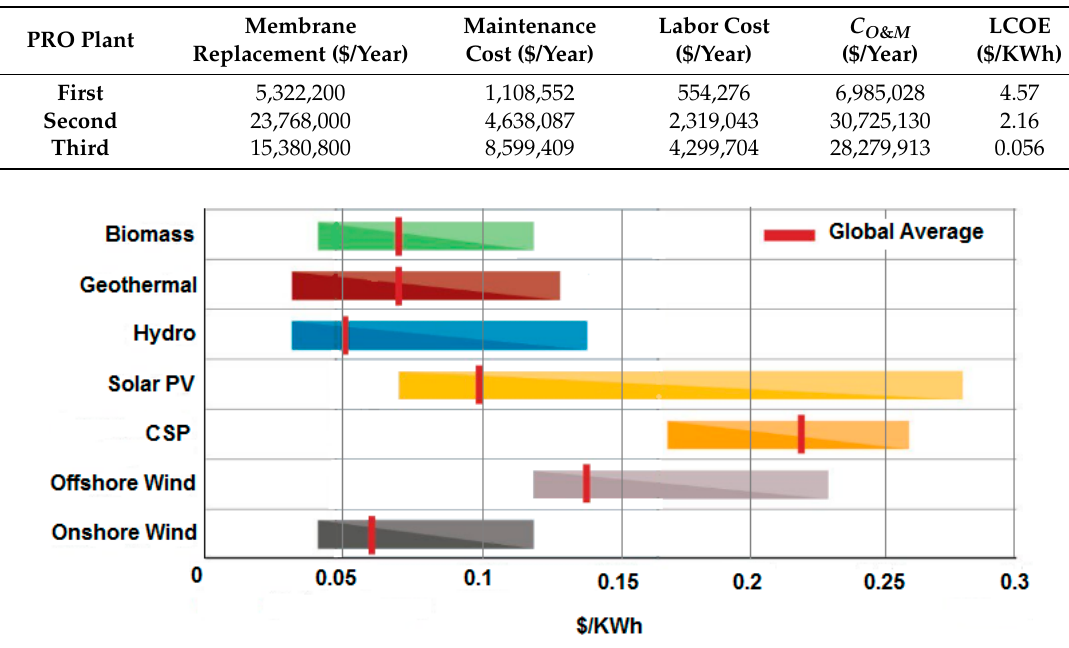
Figure 10. The levelized cost of electricity (LCOE) of renewable power generation technologies and their weighted average (2017) [44].